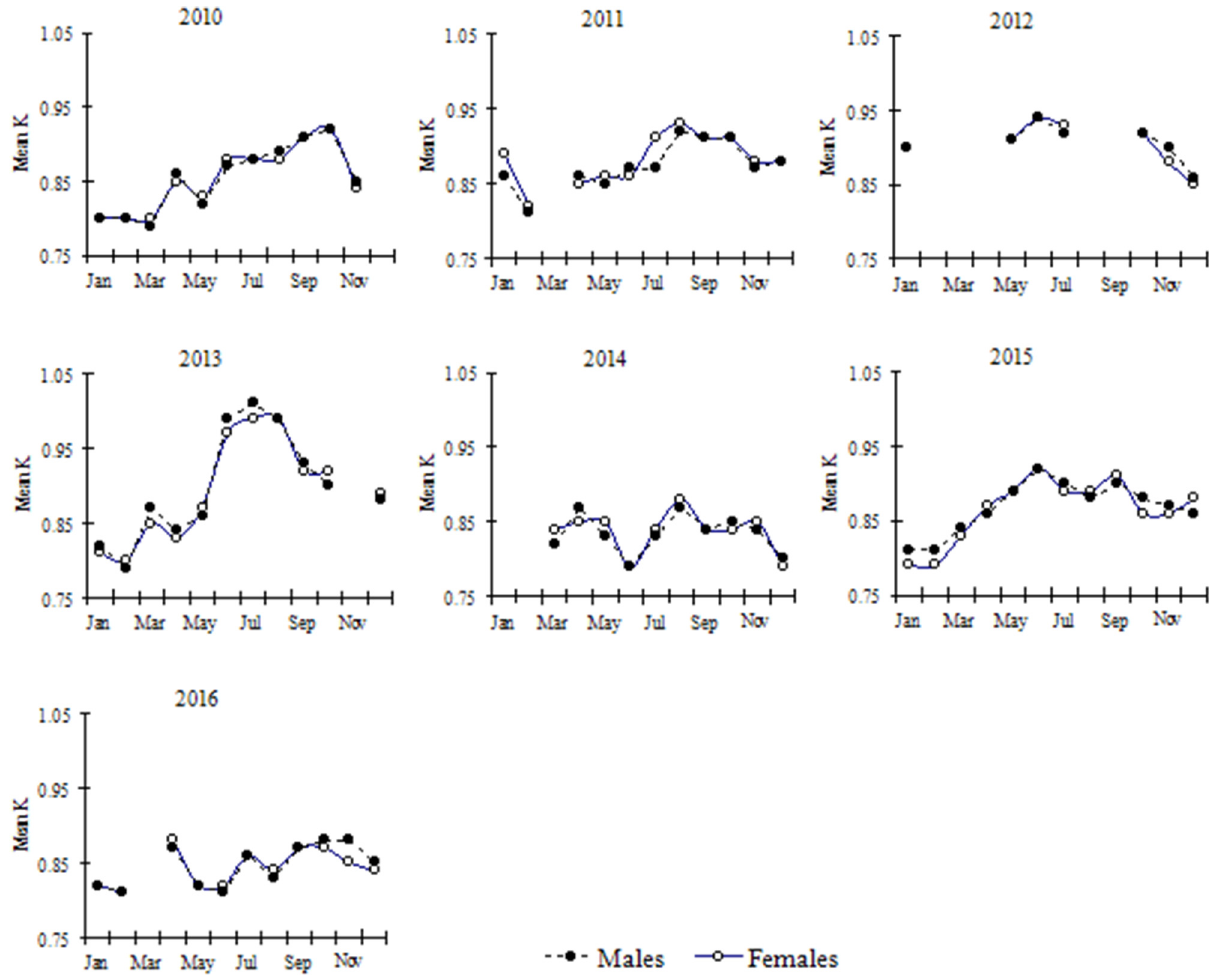
Fig. 8. Mean monthly condition factors ( K ) (males and females) for T. picturatus from north-east Atlantic waters (Portuguese